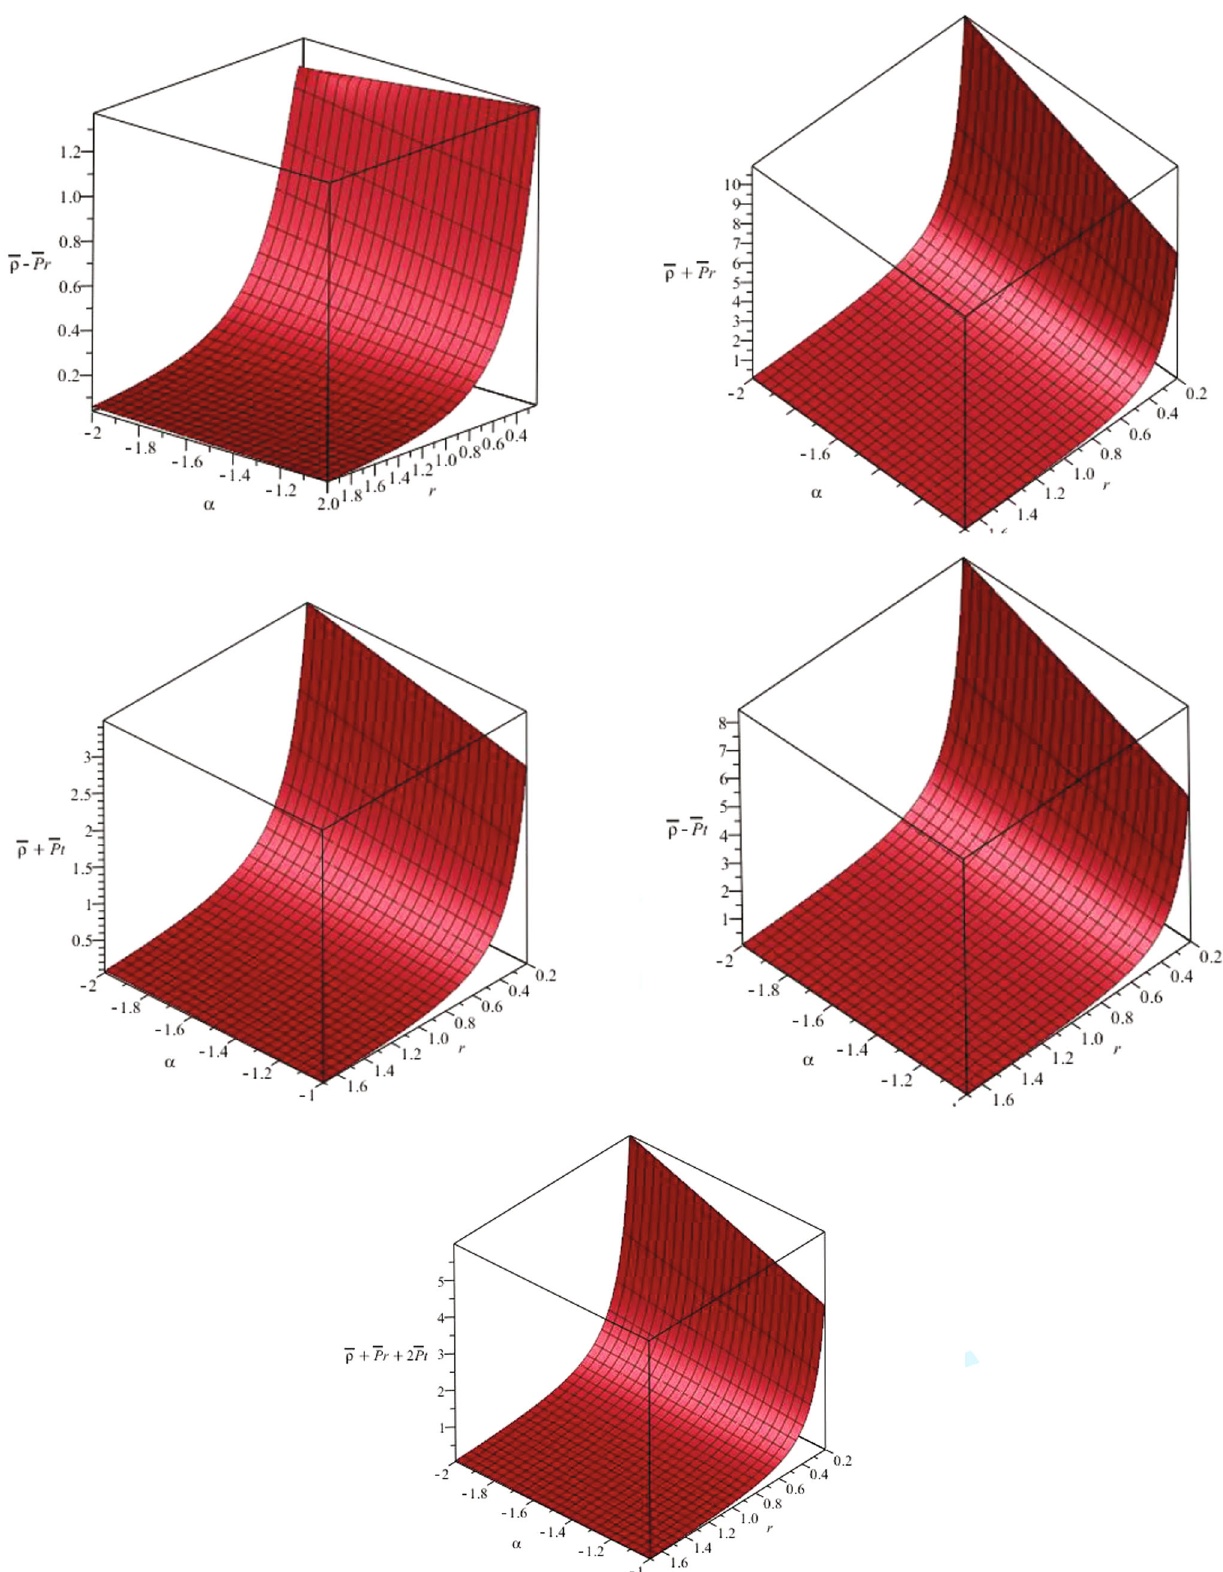
Fig. 5 Plots of energy conditions against r and α using M 0 = 1 M (cid:9) and R = ( 0 . 3 ) − 1 M (cid:9) for